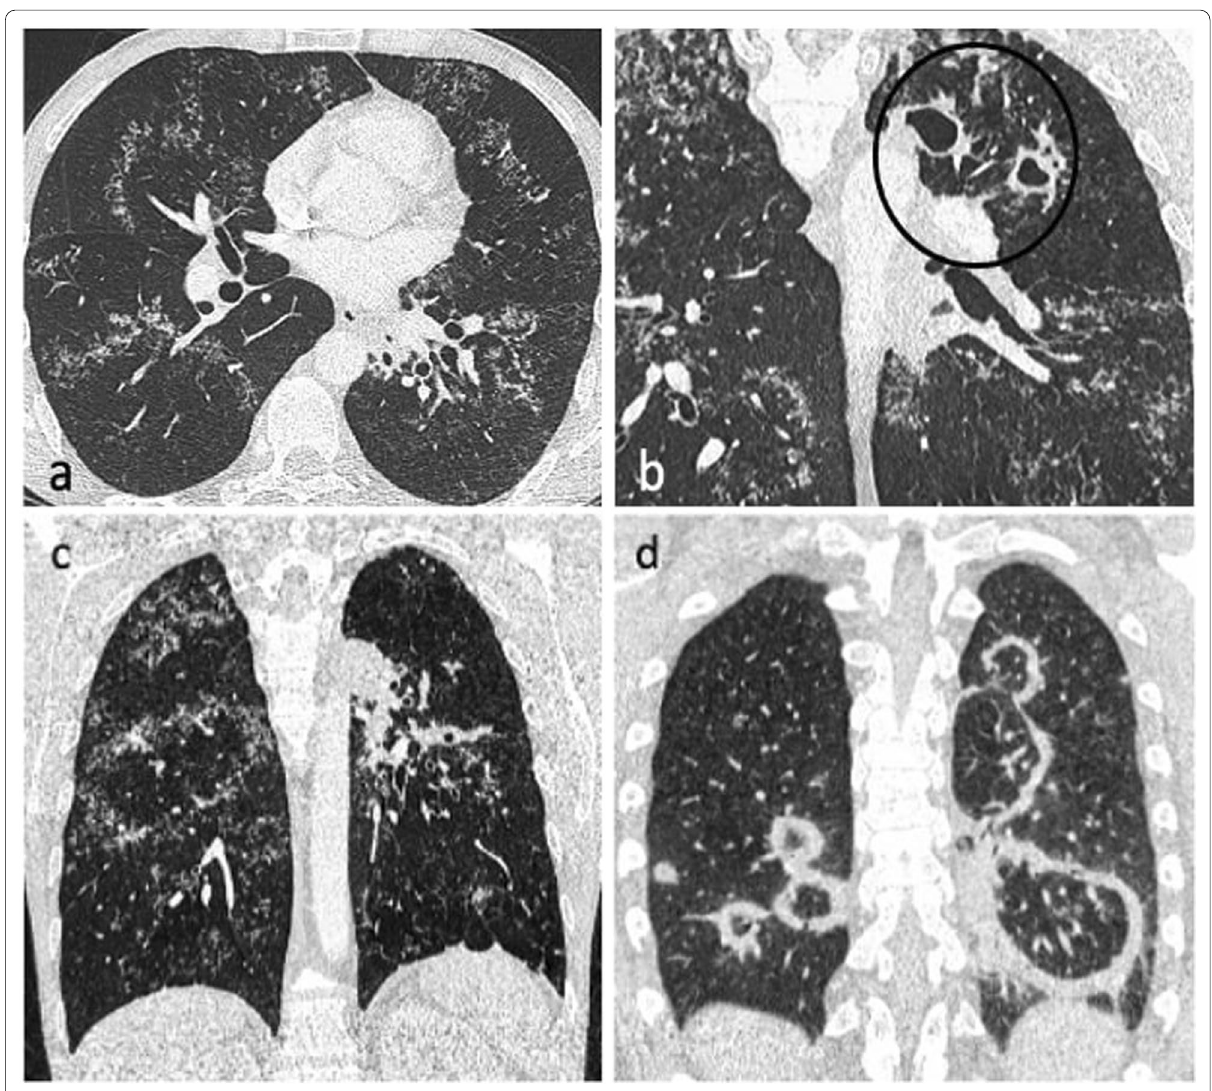
upper lobe (coronal plane— b , circled). Image ( d ) is of a 25-year-old male with cryptogenic organising pneumonia who presented with cough and night sweats. CT (lung window, coronal plane) demonstrates multiple areas of rim consolidation reversed halo